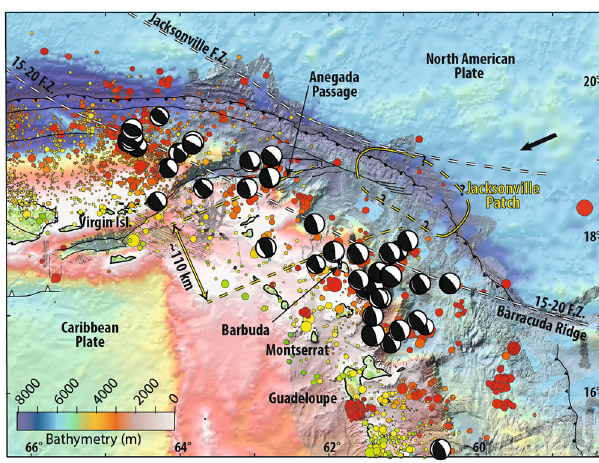
Fig. 5 Seismicity map. Map view of the seismic activity in the Northern Lesser Antilles. The circles represent the earthquakes from the EHB catalogue and the USGS PDE, sized by magnitude and colored by depth. Black focal mechanisms are thrust earthquakes from the gCMT catalogue, aggregated in two clusters separated by a 110-km large quiet zone (dashed yellow lines). Dashed white lines indicate the 15 – 20 and Jacksonville Fracture